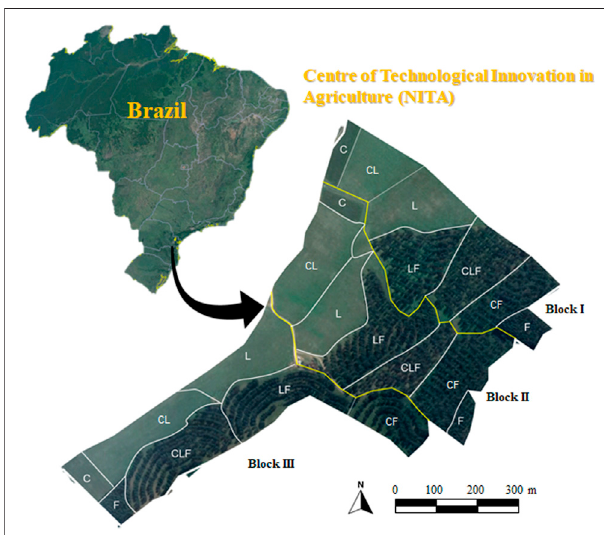
FIGURE 1 | The experimental area at the Canguiri farm of the Federal University of Paraná. Treatments: C, conventional crop production; L, livestock; F, forestry; CF, integrated crop-forestry; CL, crop-livestock; LF, livestock-forestry; CLF, crop-livestock-forestry.